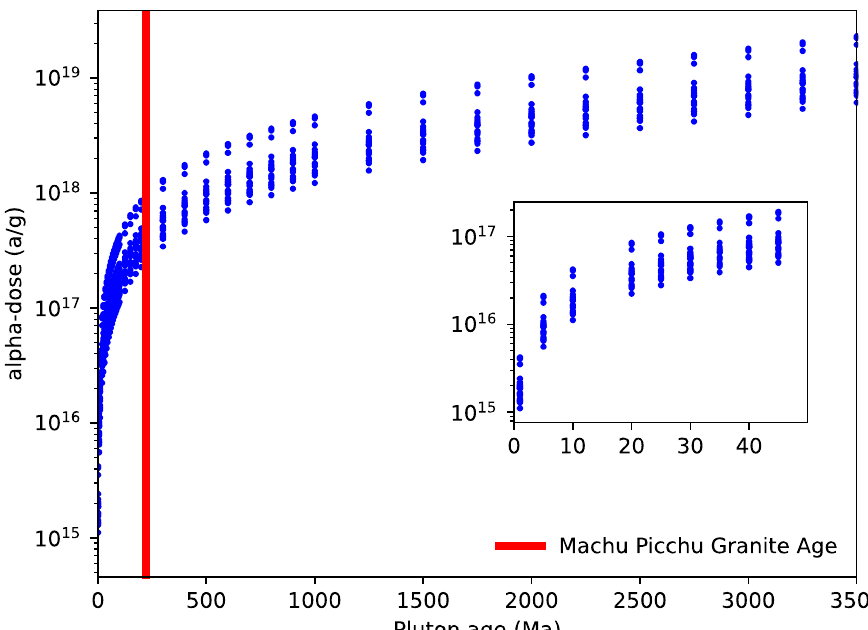
Figure 7. α -dose as a function of the age of a pluton computed for the samples of the Machu Picchu vertical profile (blue dots). The thick red vertical line corresponds to the ages of the Machu Picchu batholith, ~222 Ma, [23]. Light red horizontal bands show the α -dose values that are compatible with the ZHe data from Machu Picchu. We estimated them with the relationship between the ZHe closure temperature, the α -dose, and the estimated ZHe closure temperature from the Machu Picchu. The inset is an enlargement of the first part of the graph.